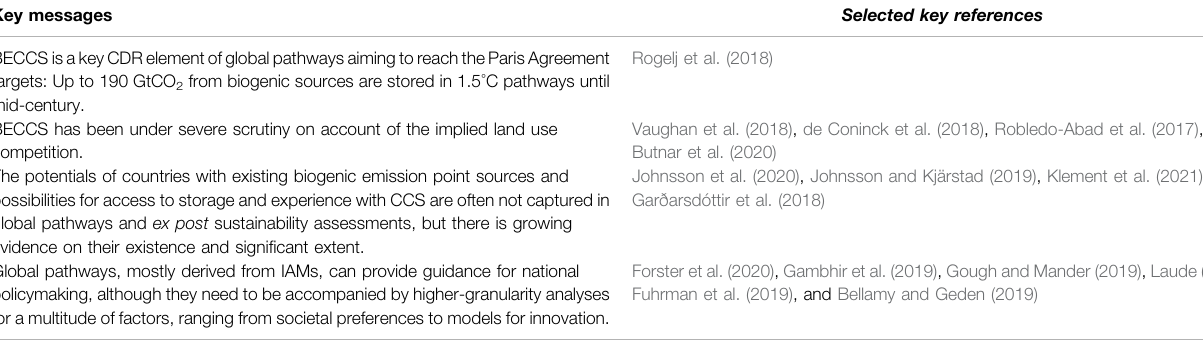
TABLE 1 | Key messages from the analysis of global BECCS